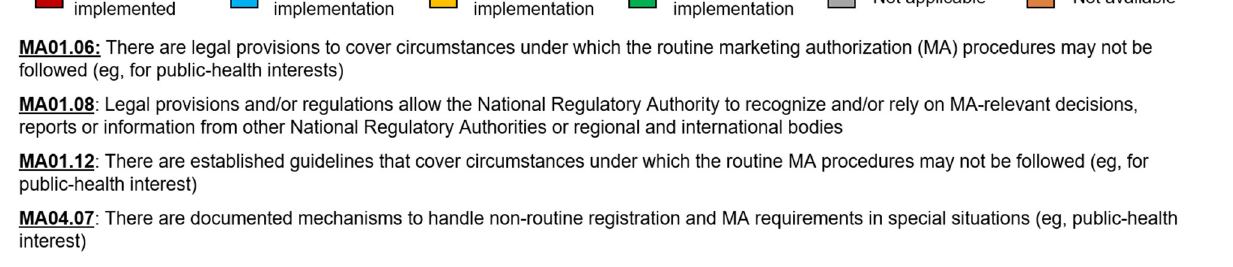
FIGURE 3 | Implementation of four WHO Global Benchmarking Tool sub-indicators related to marketing authorization during a public health emergency, among 84 Member States benchmarked from 2016 to